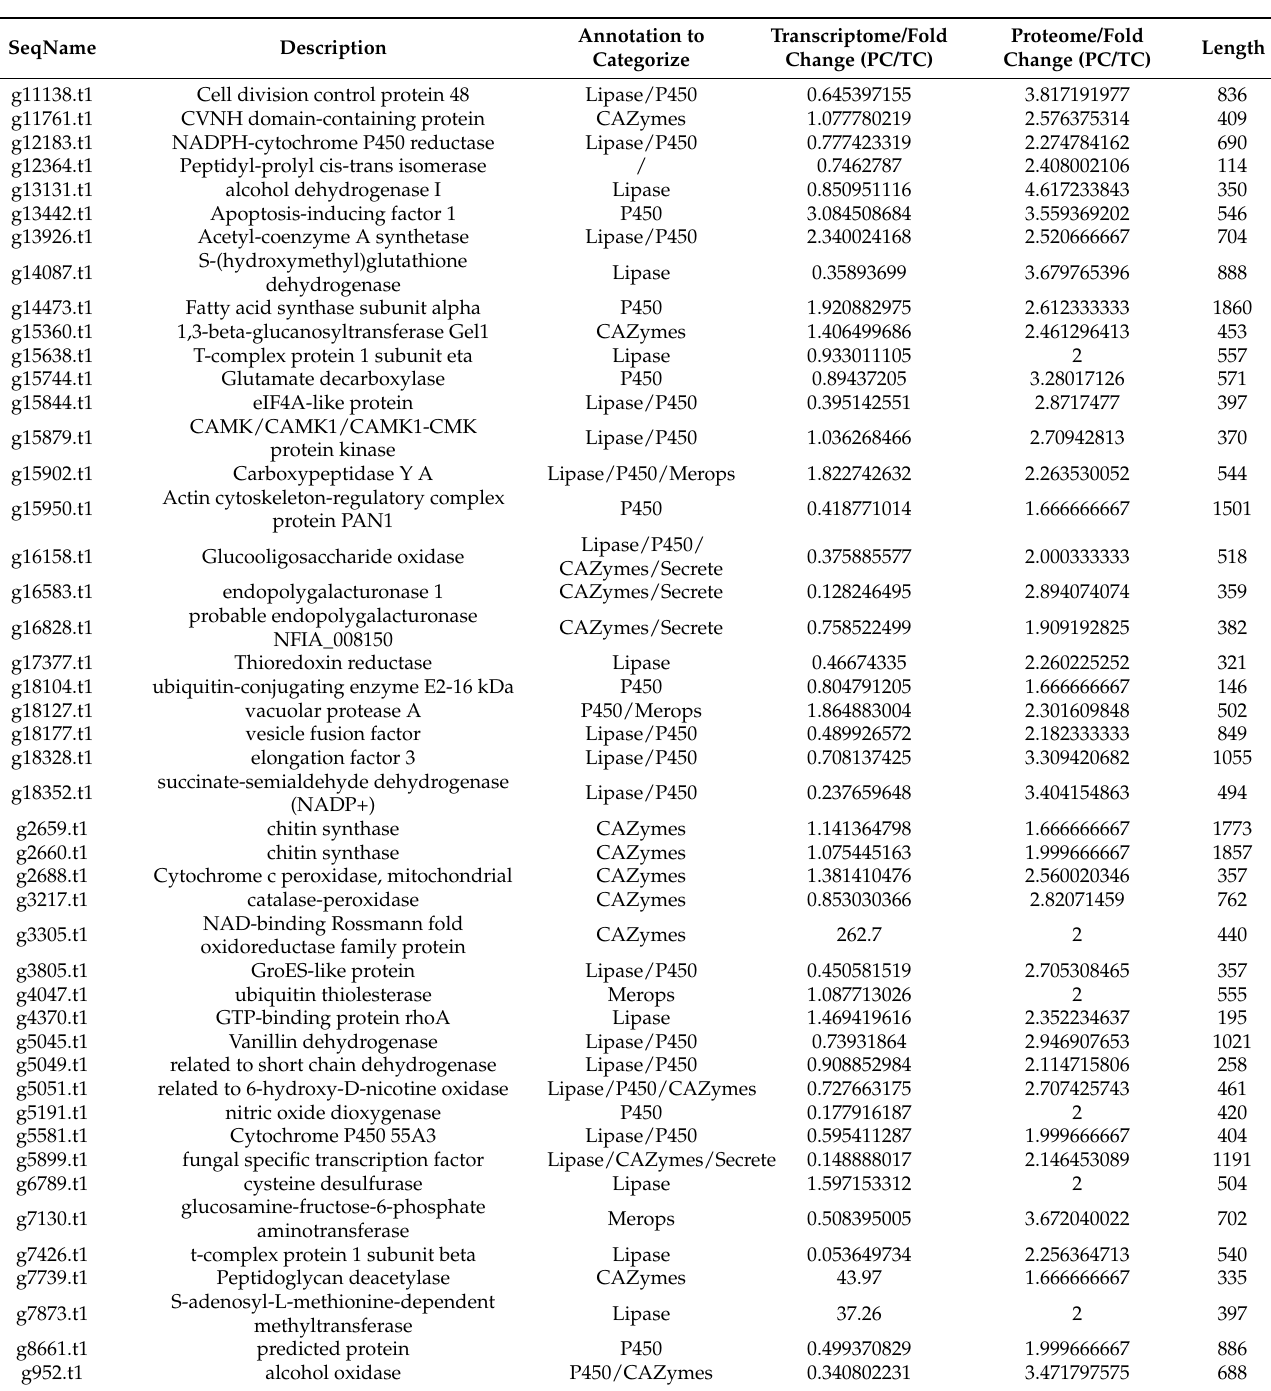
Table 2. Forty-six virulence-associated genes’ relevant